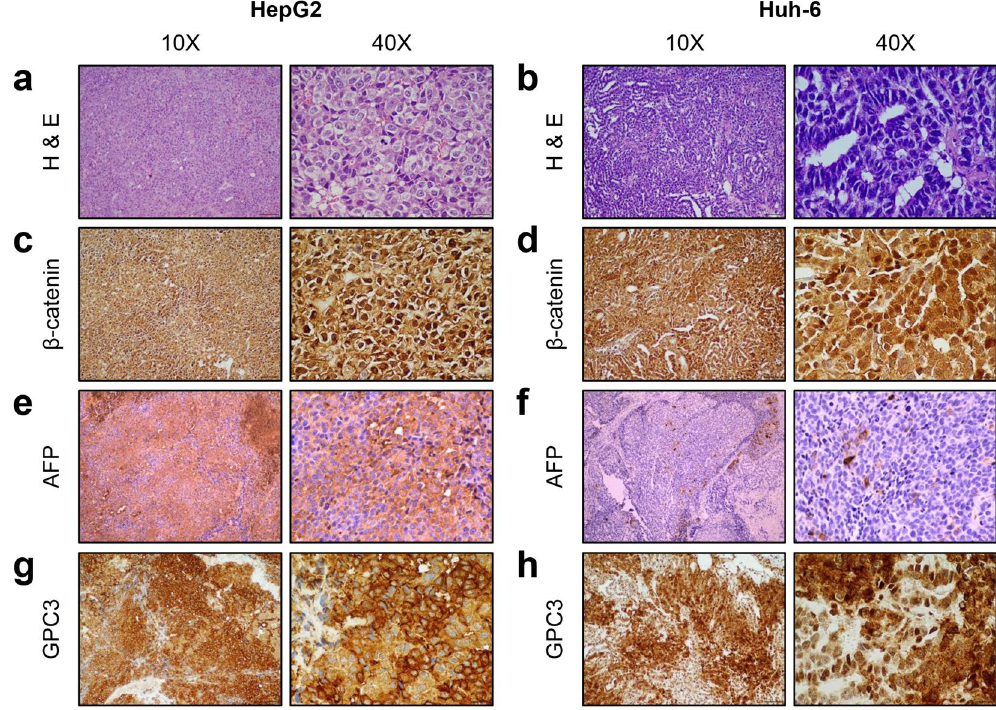
Figure 4. Histological examination of xenograft tumors. Samples representative of each xenograft tumor were stained with H&E ( a , b ) and antibodies recognizing β -catenin ( c , d ), AFP ( e , f ), and GPC3 ( g , h ), three proteins known to be elevated in HB. ( a , b ) HepG2 ( a ) shows classic HB embryonal morphology while Huh-6 ( b ) demonstrates areas of embryonal HB histology and a papillary pattern. ( c , d ) Cytoplasmic and nuclear β -catenin expression in HepG2 ( c ) and Huh-6 ( d ) samples. ( e , f ) AFP expression is elevated in HepG2 samples ( e ) but not in Huh-6 samples ( f ). ( g , h ) High GPC3 expression in HepG2 ( g ) and Huh-6 ( h ) tumors. Scale bars represent